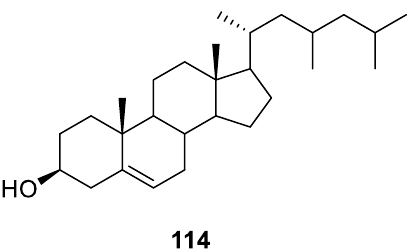
Figure 14. Chemical structure of compound 114 from lichen-associated actinomycetota.